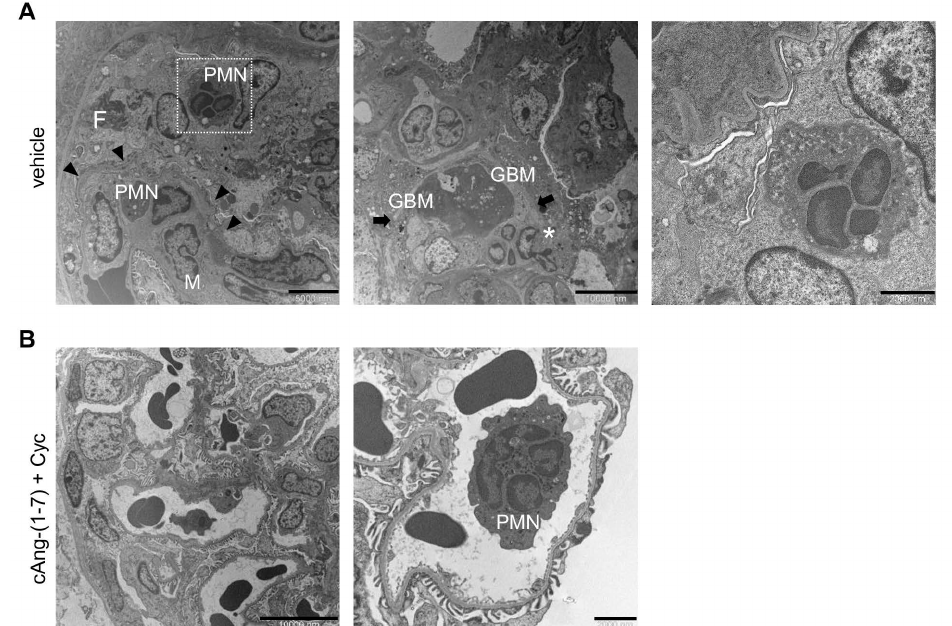
Figure 5. Addition of cAng-(1-7) to cyclophosphamide ameliorates glomerular ultrastructural abnor- malities in glomeruli of rats with ANCA-GN. ( A ) Representative transmission electron microscopy images of glomeruli in WKY rats with ANCA-GN given vehicle showing the following: left panel, a crescentic lesion with fibrin deposits (F) associated with accumulation of polymorphonuclear neu- trophils (PMN) and mononuclear cells (M). Arrowheads indicate podocyte foot process effacement; middle panel, glomerular basement membrane (GBM) ruptures (arrows), and cellular extravasation (asterisk); right panel, insert of the left panel showing a degranulated neutrophil. ( B ) Representative glomeruli from rats with ANCA-GN treated with cAng-(1-7) plus cyclophosphamide showing the fol- lowing: left panel, well-preserved glomerular architecture; right panel, circulating non-degranulated